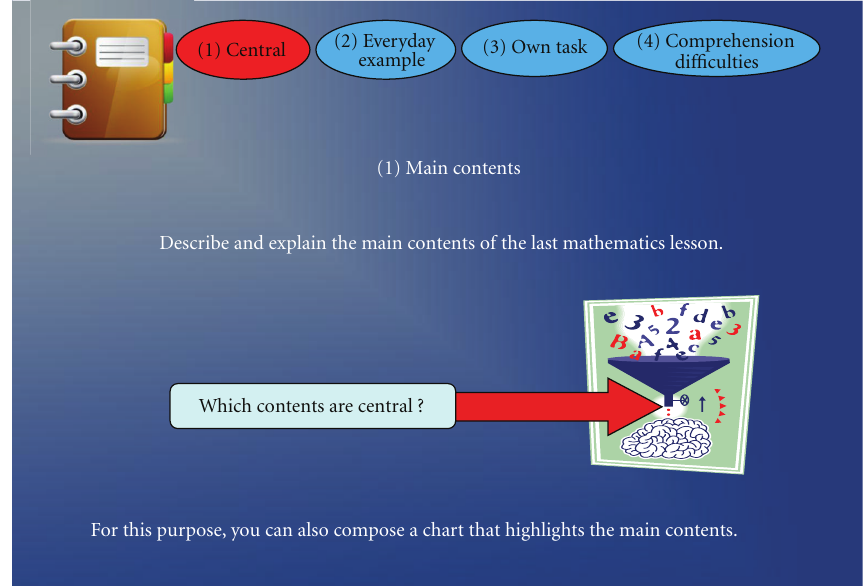
Figure 1: Screenshot of the introductory presentation: Introduction of the organisation prompt (translated from German).